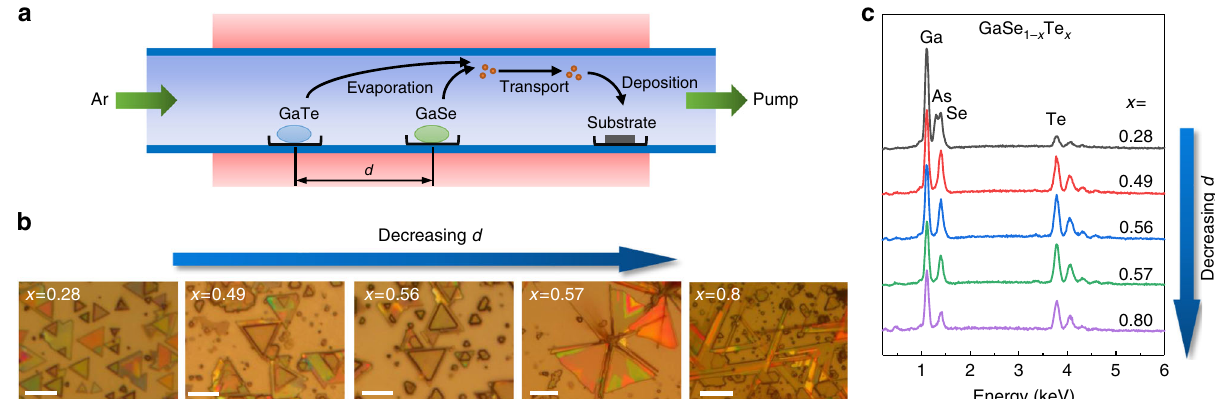
Fig. 1 Synthesis process and morphology of GaSe 1 − x Te x nanostructures. a Schematic of the synthesis process of GaSe 1 − x Te x nanostructures in a single- zone tube furnace. b Optical images of the GaSe 1 − x Te x nanostructures grown at different d between GaTe and GaSe source. Corresponding x values are shown on the top left corner of each image. Scale bar = 5 μ m for x = 0.28, 0.49 and 0.56; 10 μ m for x = 0.57 and 0.8. c EDS spectra of the GaSe 1 − x Te